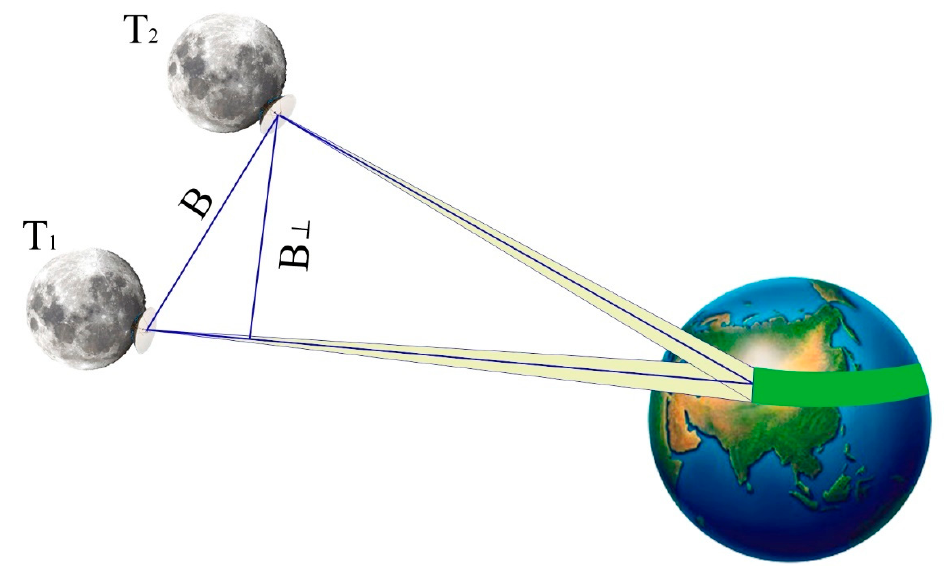
Figure 6. Single-station observation geometry of moon-based interferometric synthetic aperture radar (InSAR). The T 1 and T 2 represent two different time points.